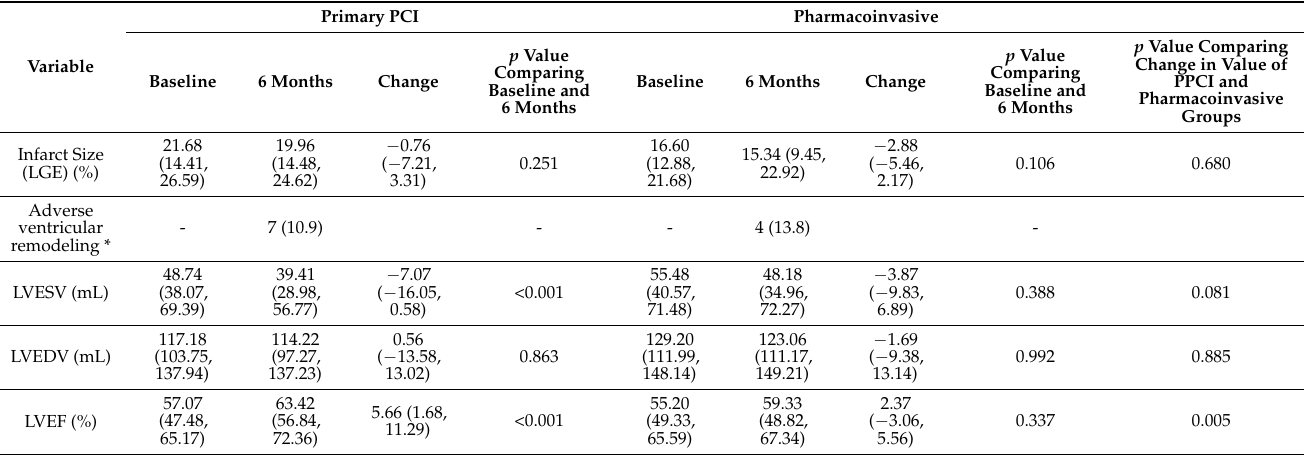
Table 3. Magnetic resonance imaging parameters at baseline and at 6-months for the primary PCI and pharmacoinvasive groups.